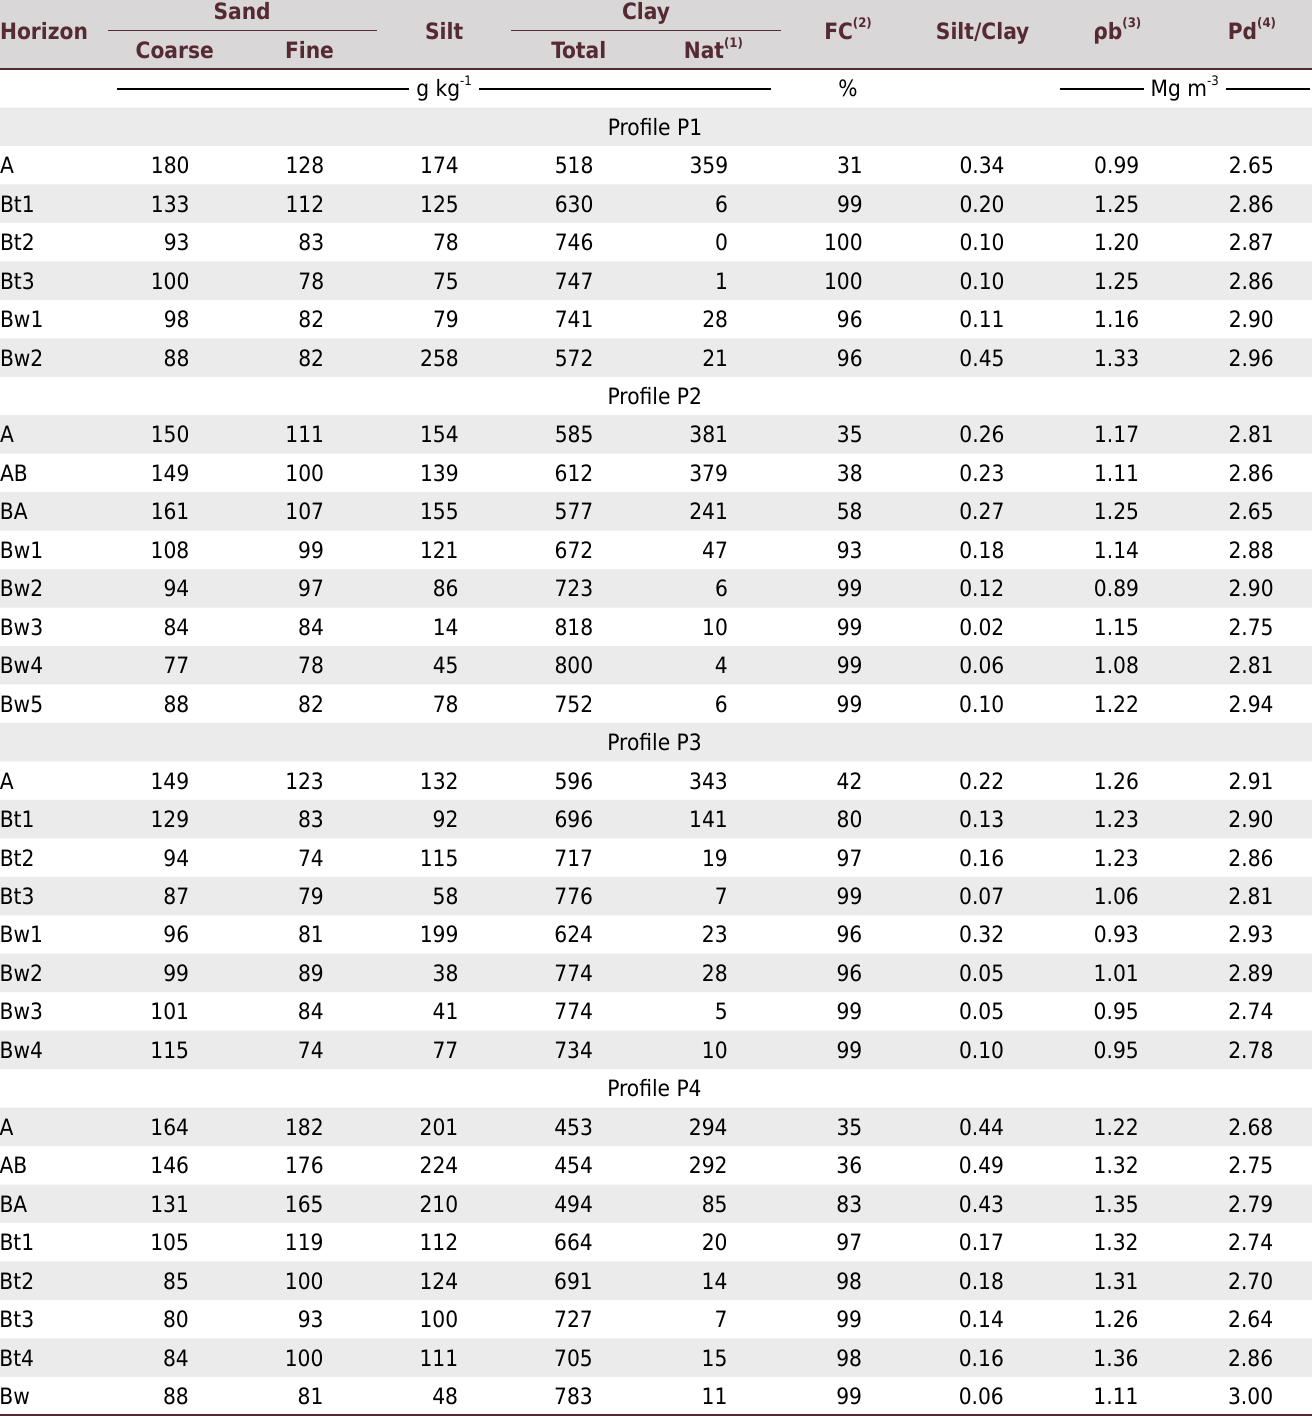
Table 2. Physical properties of the sampled soils in the Rio de Janeiro State, Southeastern Brazil Sand Horizon Silt